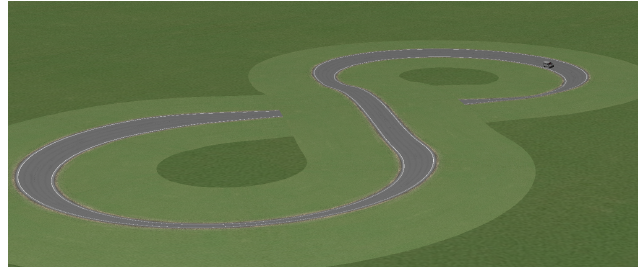
Figure 10. Global view for Test 2.